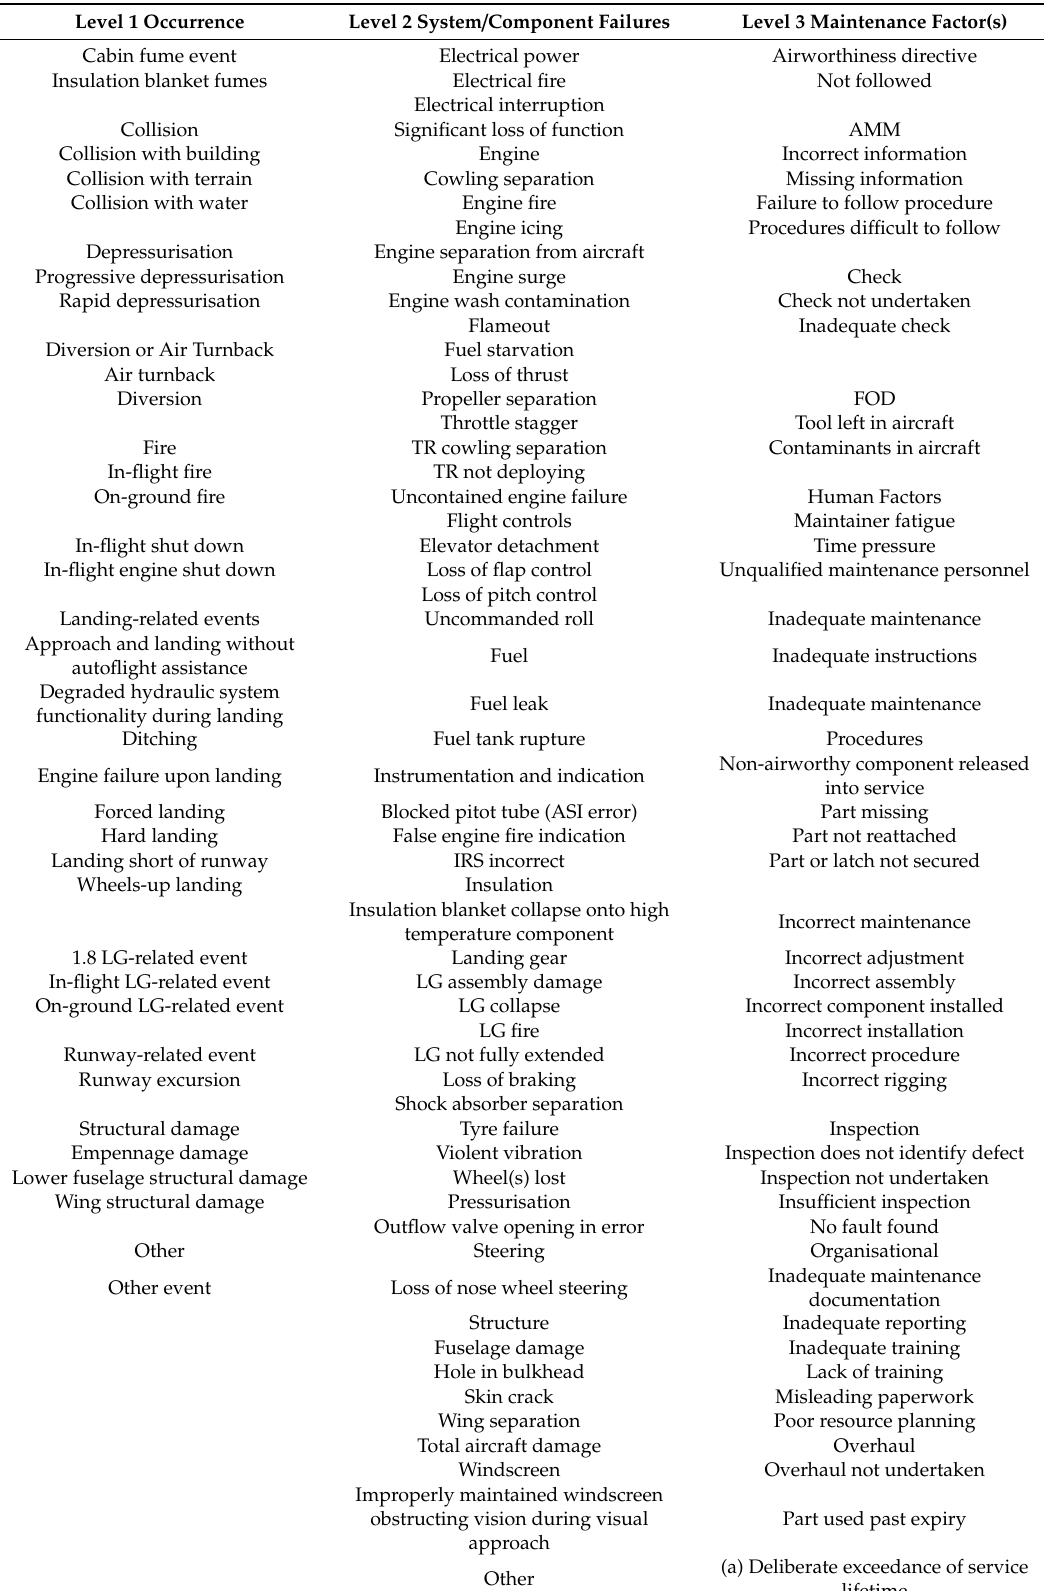
Table A2. MxFACS Taxonomy (Insley,